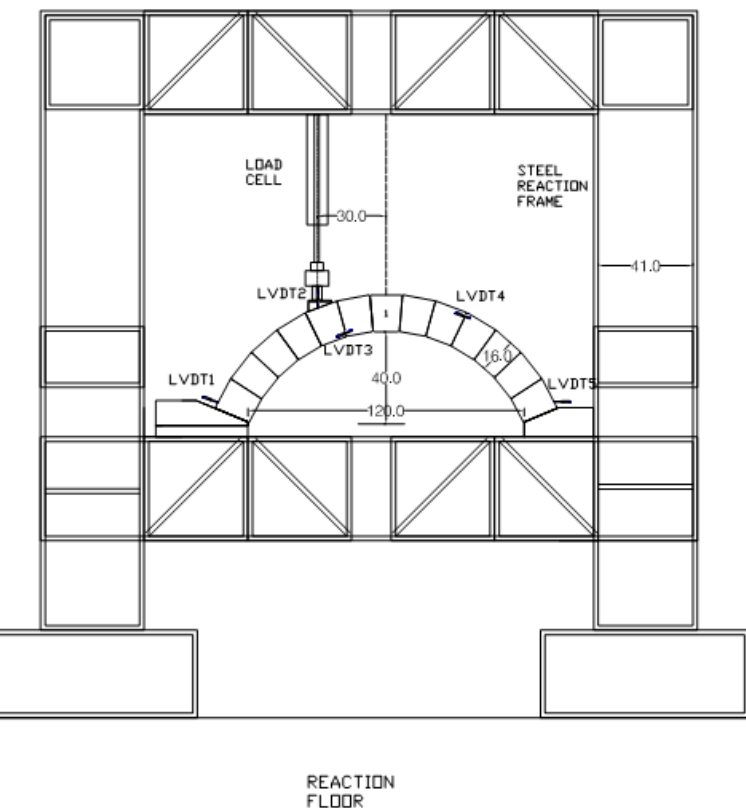
Figure 1. Masonry Stone Arch Prototype Quasi-Static Experiment, reproduced from [35].